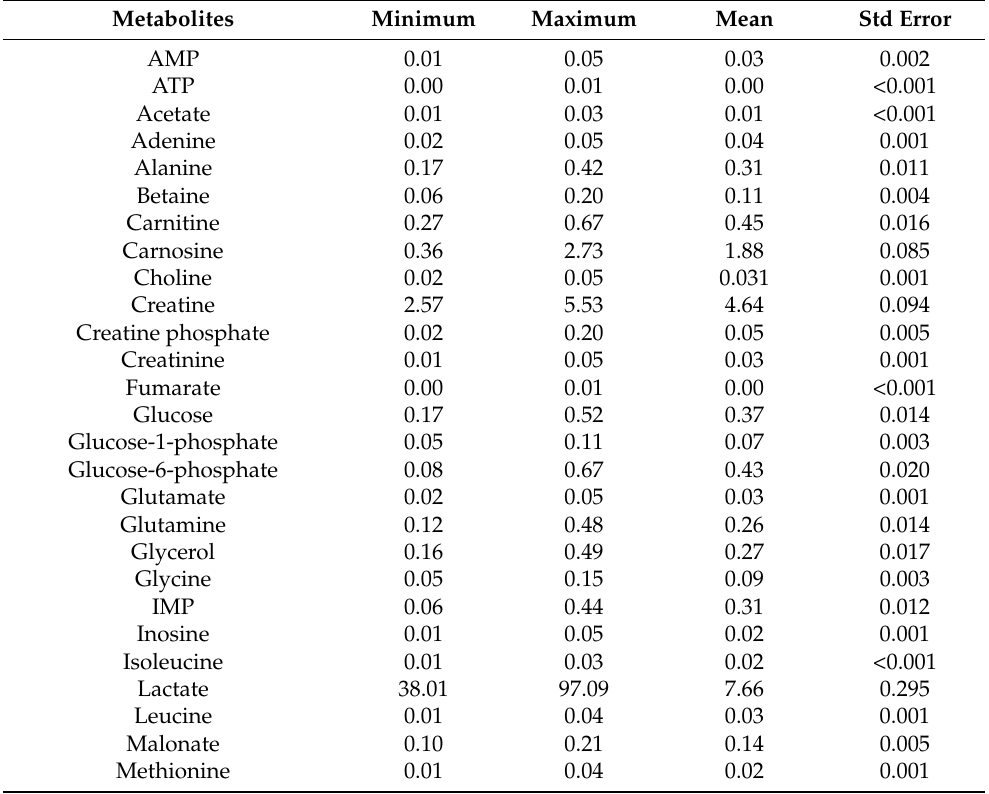
Table 1. Descriptive analysis of metabolites concentrations (mg/g of fresh